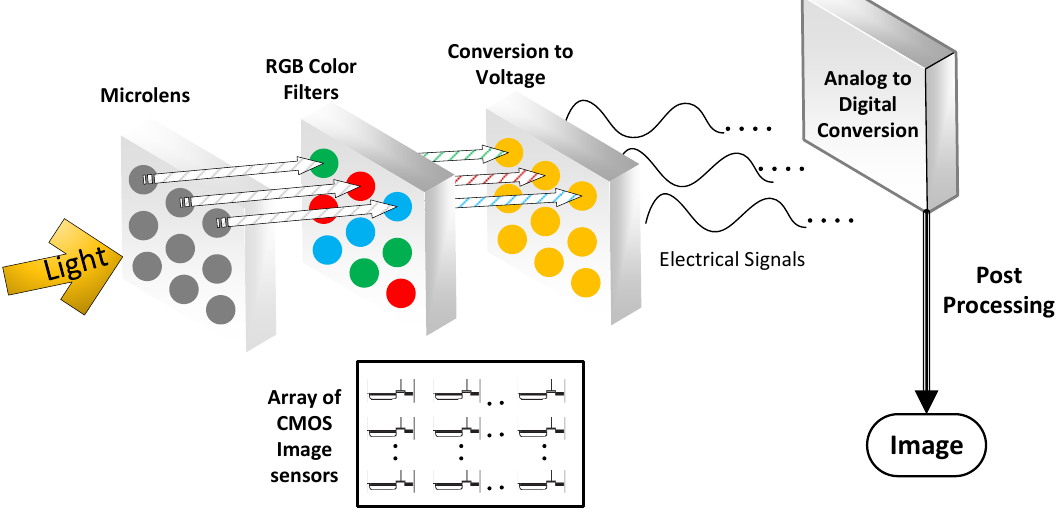
Figure 1. Pipeline of CMOS imaging acquisition system (adapted from [38]).